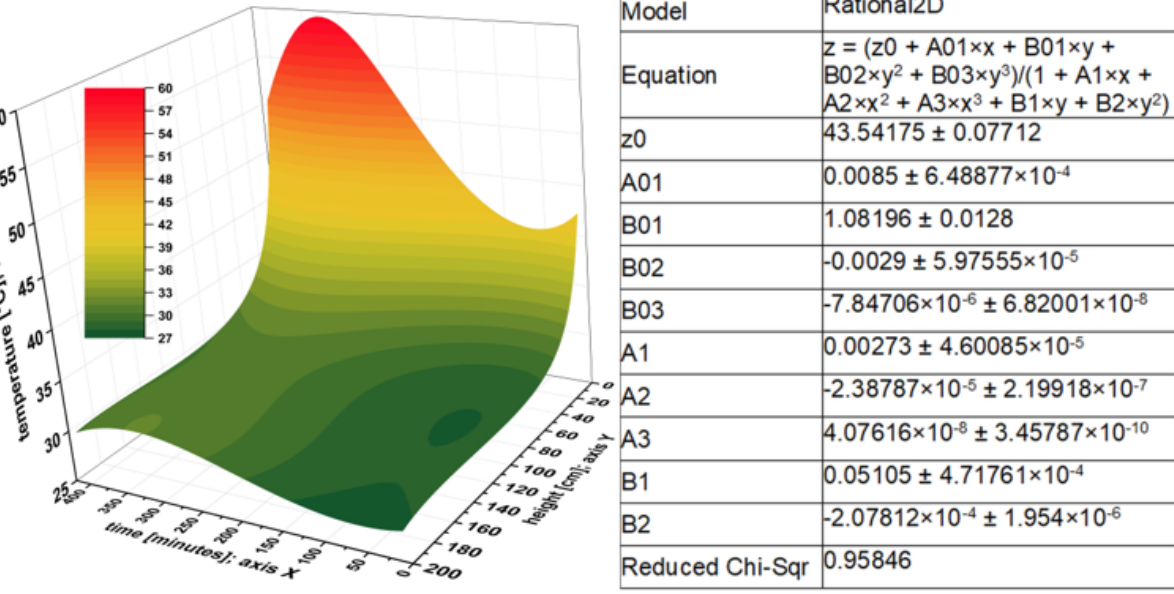
Figure 10. Fitted model of relationship between surface temperature (axis Z) and adjacent air mass temperature at different heights (axis Y “height”) and length of exposure to solar radiation during cloudless tropical day (axis X “time”) described by rational 2D